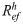
Estimation of Model PMAL in Period 4 (October/2008—September/2012).(a) observed incidence (O) and adjusted i (E), (b) m3/m, (c) Refh (h) and Refm (m), and (d) Ref=Refh×Refm.